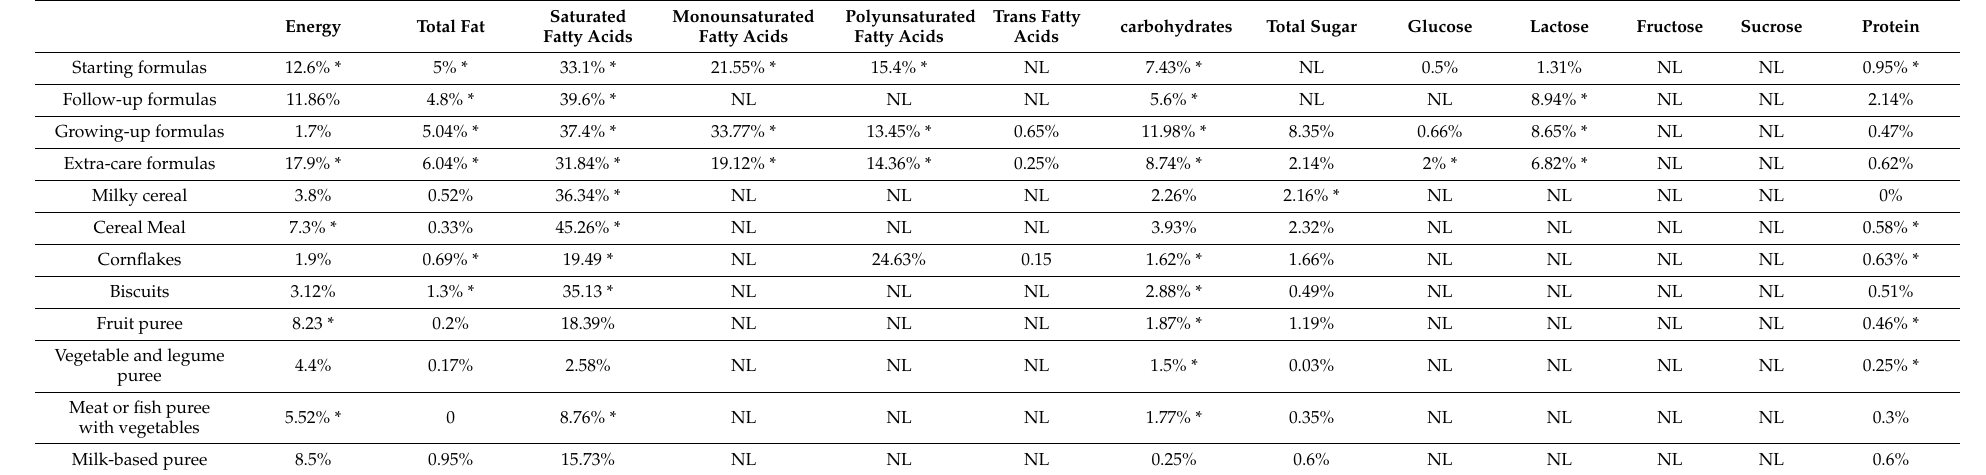
Table 3. Table summarizing the difference between measured and labeled